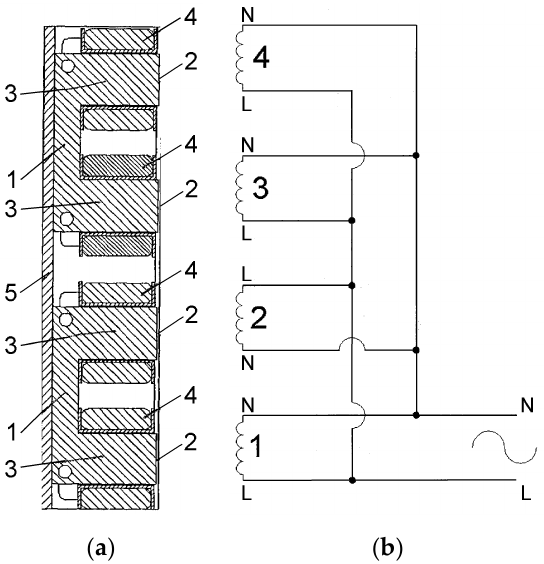
Figure 11. Rail induction heating module: ( a ) module design; 1: inductor, 2: poles, 3: magnetic core, 4: winding, and 5: mounting plate; ( b ) wiring diagram of winding for a single module [17].